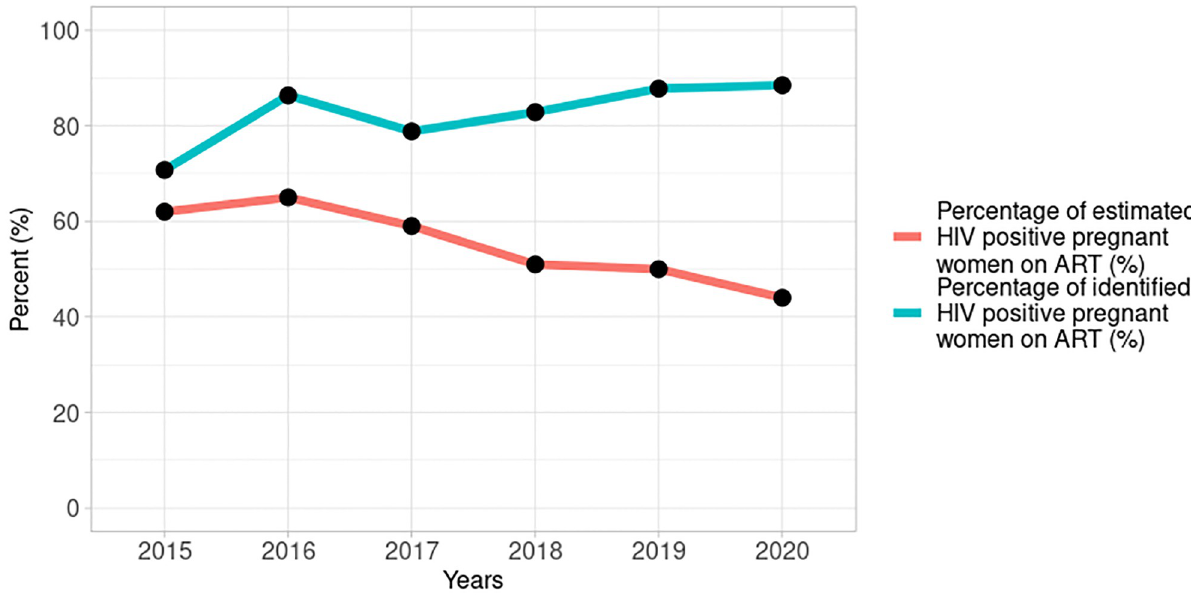
Fig 10. Percentage of estimated and identified HIV positive pregnant women on antiretroviral treatment from 2015–2020.